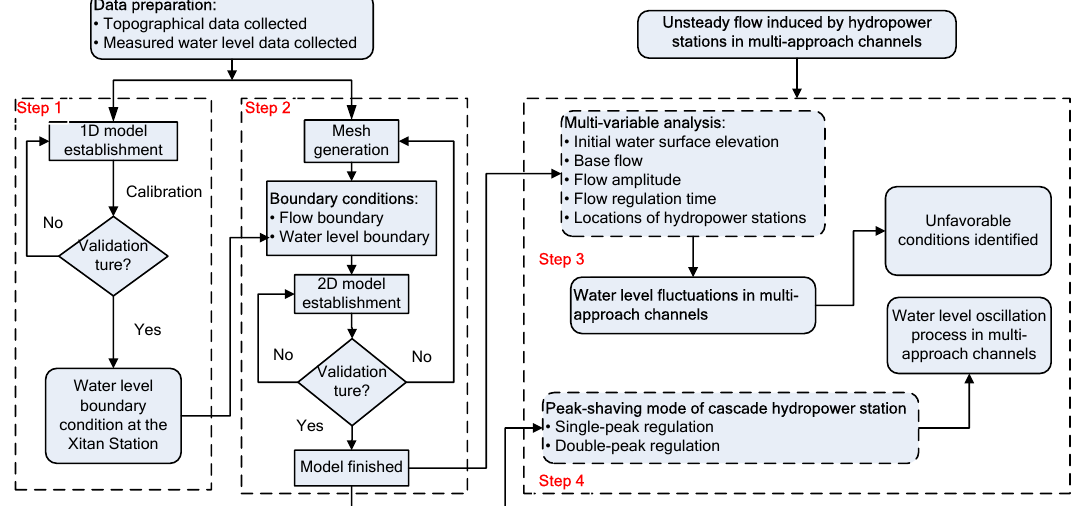
Figure 3. The flowchart of the analysis conducted in this study.